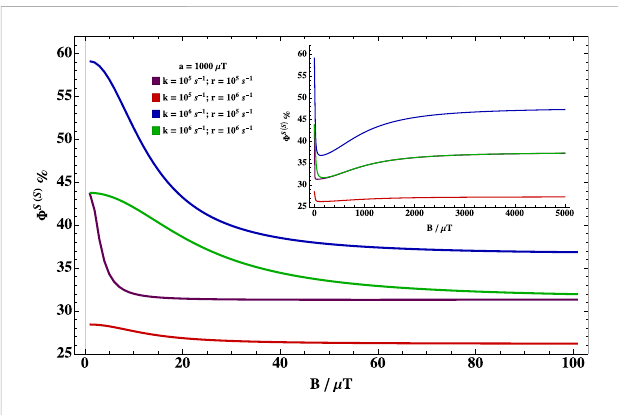
FIGURE 1 Dependence of the eigenenergies on B . Eigenenergies of three statesthatoverlapwiththesingletinitialstateasafunctionoftheapplied magnetic fi eld with a hyper fi ne coupling constant of 1,000 μ T.